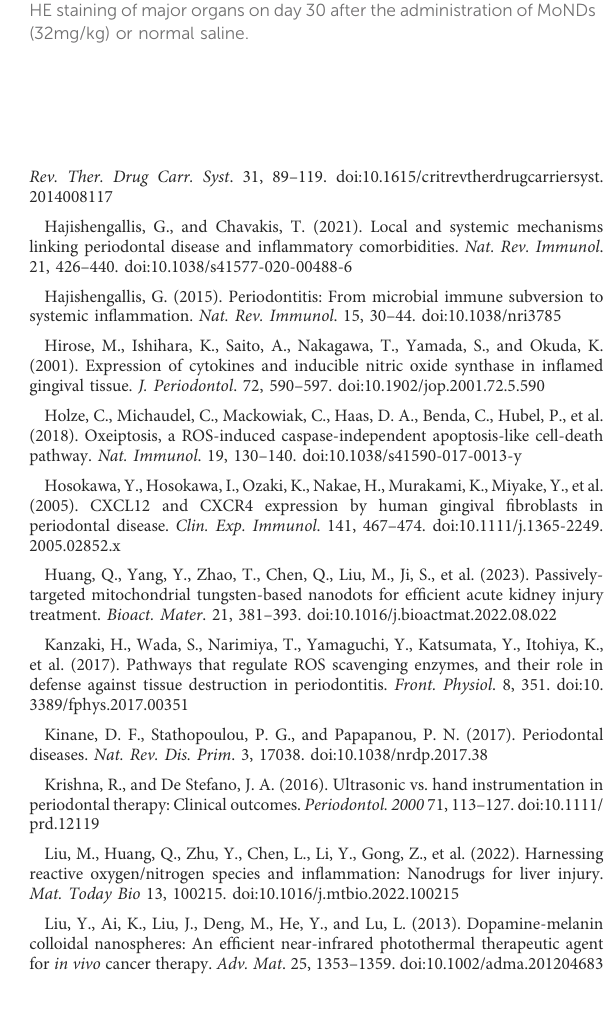
SUPPLEMENTARY FIGURE 1 XPS O 1s spectrum of MoNDs. SUPPLEMENTARY FIGURE 2 Western bolt analysis of Vimentin proteins in gingival fi broblast. SUPPLEMENTARY FIGURE 3 HE staining of major organs on day 30 after the administration of MoNDs (32mg/kg) or normal